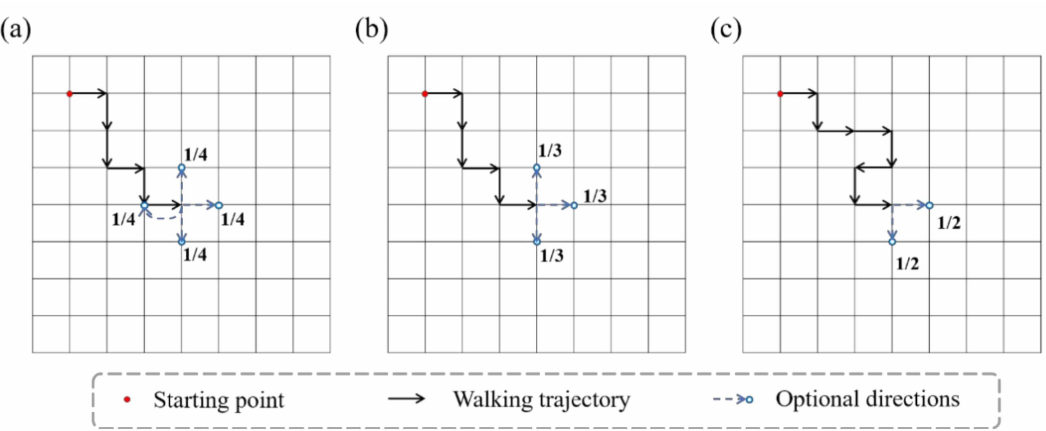
Figure 1. Schematics of RW model and SAW model. (The red dot is the starting point, the black arrow represents the walking path, and the blue arrow represents the optional direction for the next step.) ( a ) The RW model. There are four optional directions at every moment. ( b ) The SAW model cannot go back. ( c ) The SAW model cannot select points that are already occupied.